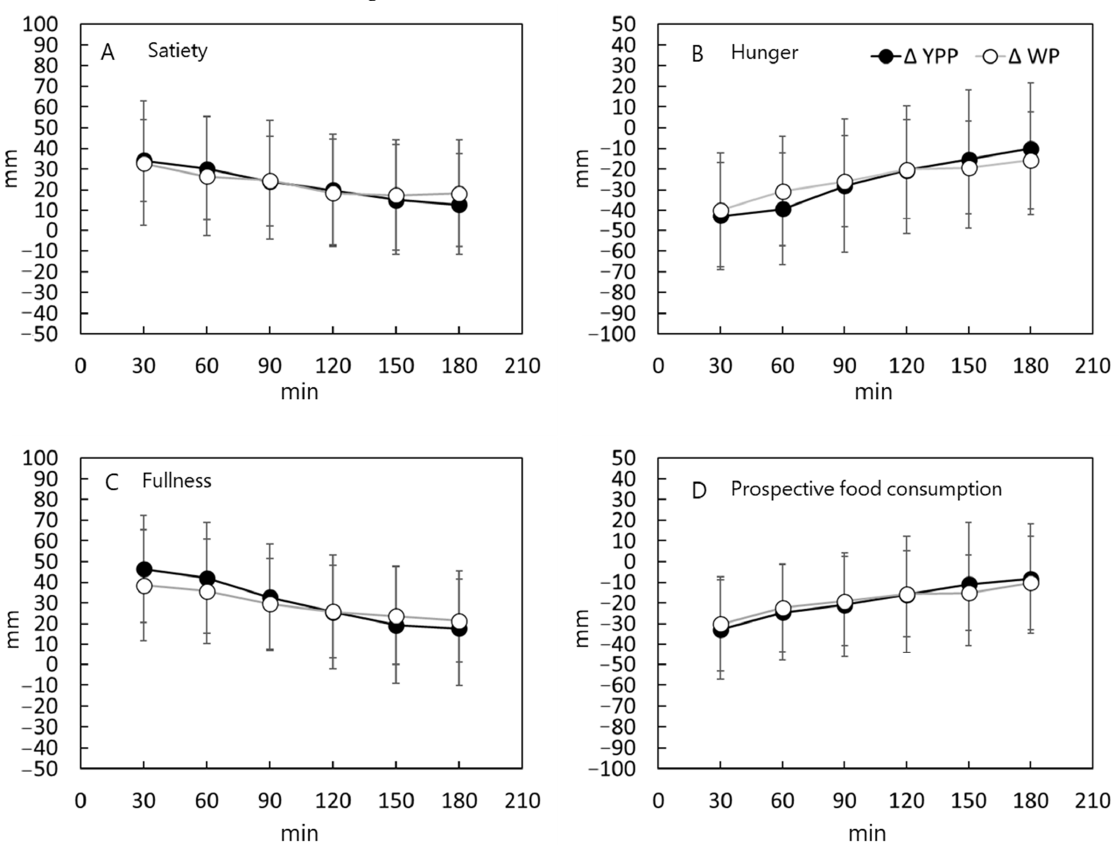
Figure 3. Assessment of satisfaction, hunger, and how much more individuals could eat after the first meal of YPP or WP of the same weight using the VAS method. A questionnaire using a 100 mm Visual Analogue Scale (VAS) was used to evaluate the results at 30, 60, 90, 120, 150, and 180 min from the start of YPP or WP intake. The four questions asked included: ( A ) how satisfied the subjects felt (about food or eating); ( B ) how hungry they were; ( C ) how full they were; and ( D ) how much they could eat if they were to eat at that